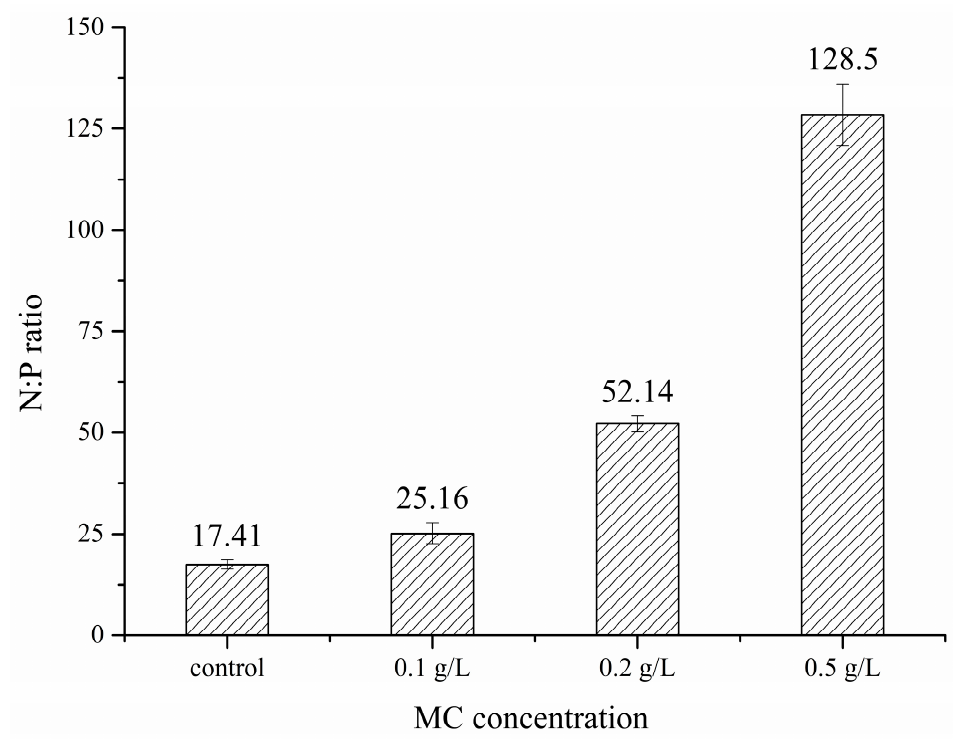
Figure 10. The absorption ratios of DIN and DIP during the incubation of P. globosa